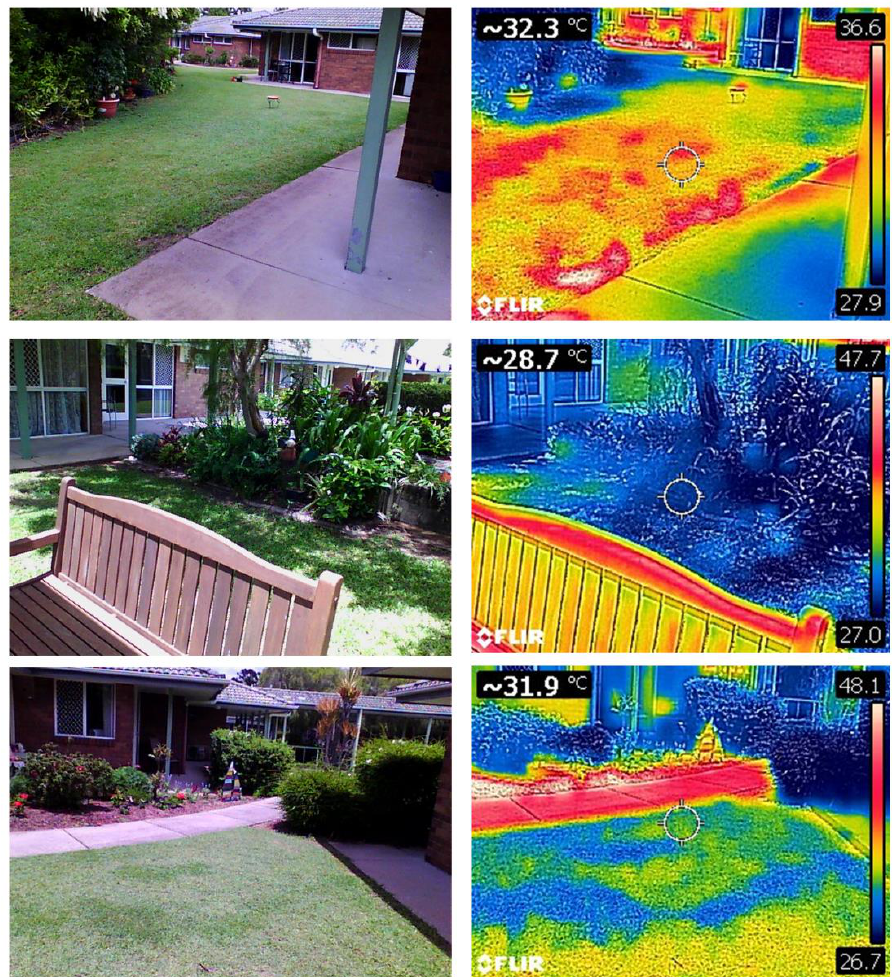
Figure 4. Thermal images and corresponding site photos for Bli Bli ACF in sectors BB5 ( top and bottom ) and BB6 ( center ). Thermal images were taken in the summer (29 January 2021) between 10:45 a.m. and 12:15 p.m. (Image Source: Author). Refer to Supplementary Materials for additional images and locations taken.